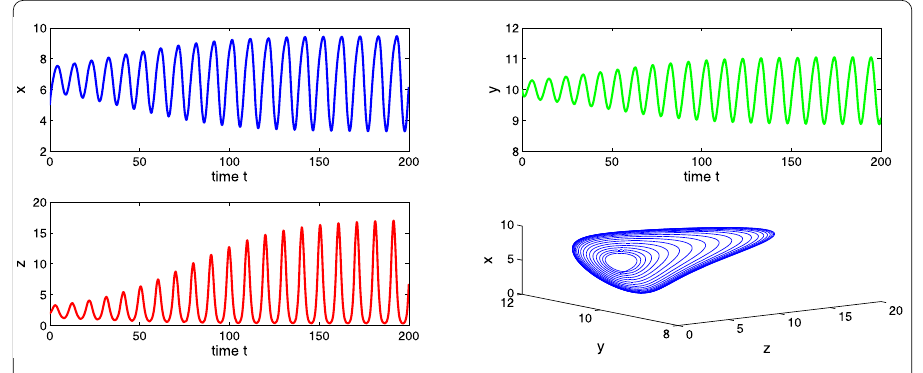
Figure 9 Time evaluation curve and three-dimensional phase portrait of the system for the parameter values a